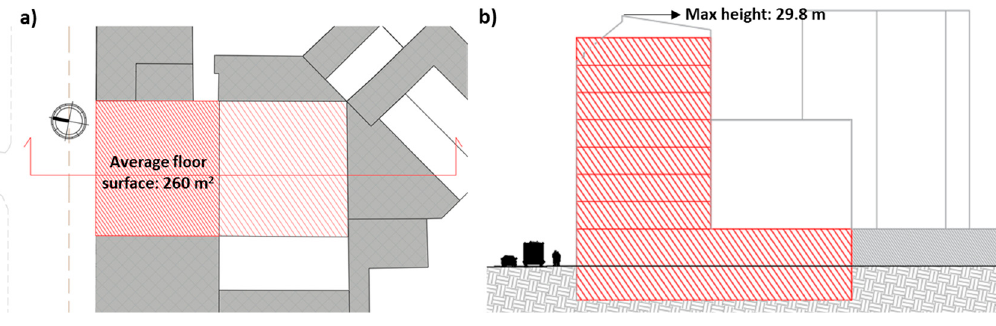
Figure 2. Plan ( a ) and section ( b ) views of the building area.